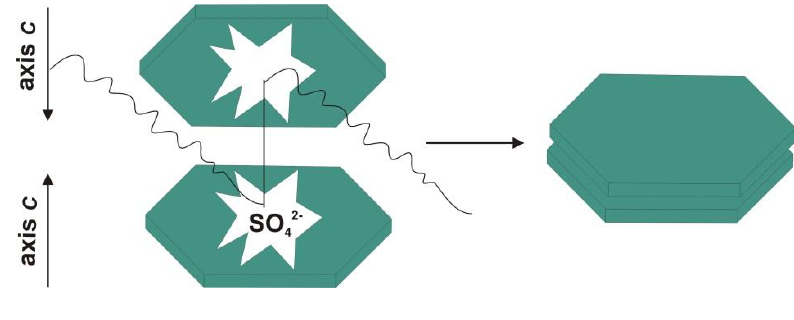
Figure 2. Effect of sodium dodecyl sulfate (SDS) surfactant on the structure of a ZnO crystal (created based on [45] with permission from Elsevier